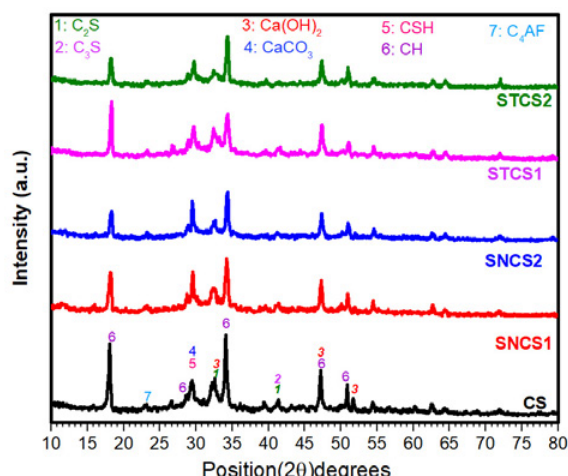
Figure 7. XRD patterns of the control sample (CS) and reinforced cement paste samples at the ages of 3 and 28 days.